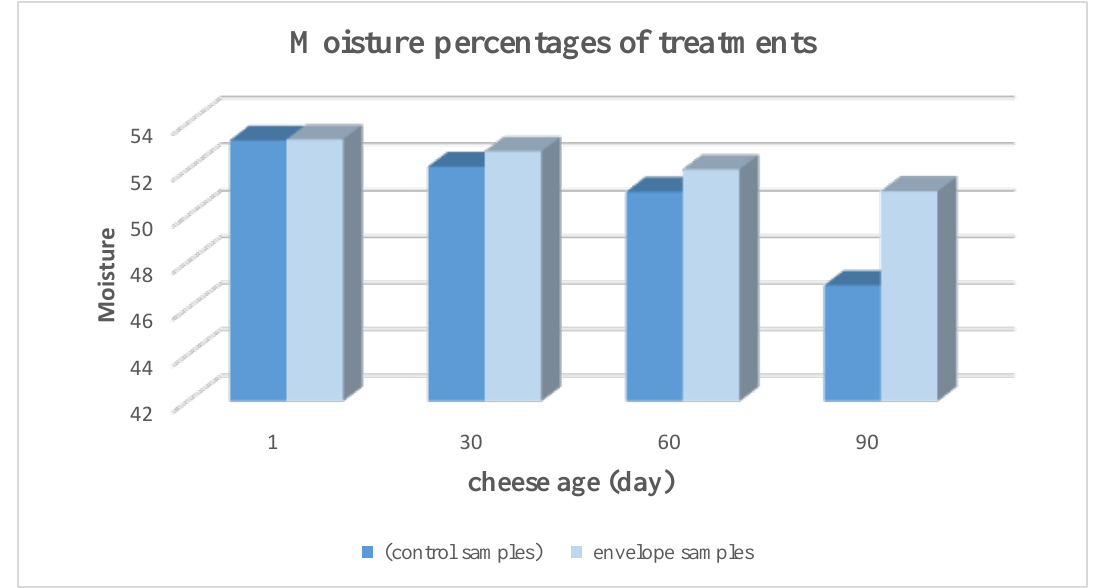
Figure 1: Moisture percentages of treatments for unwrapped mozzarella cheese (control sample) and cheese samples coated (enveloped sample) during storage